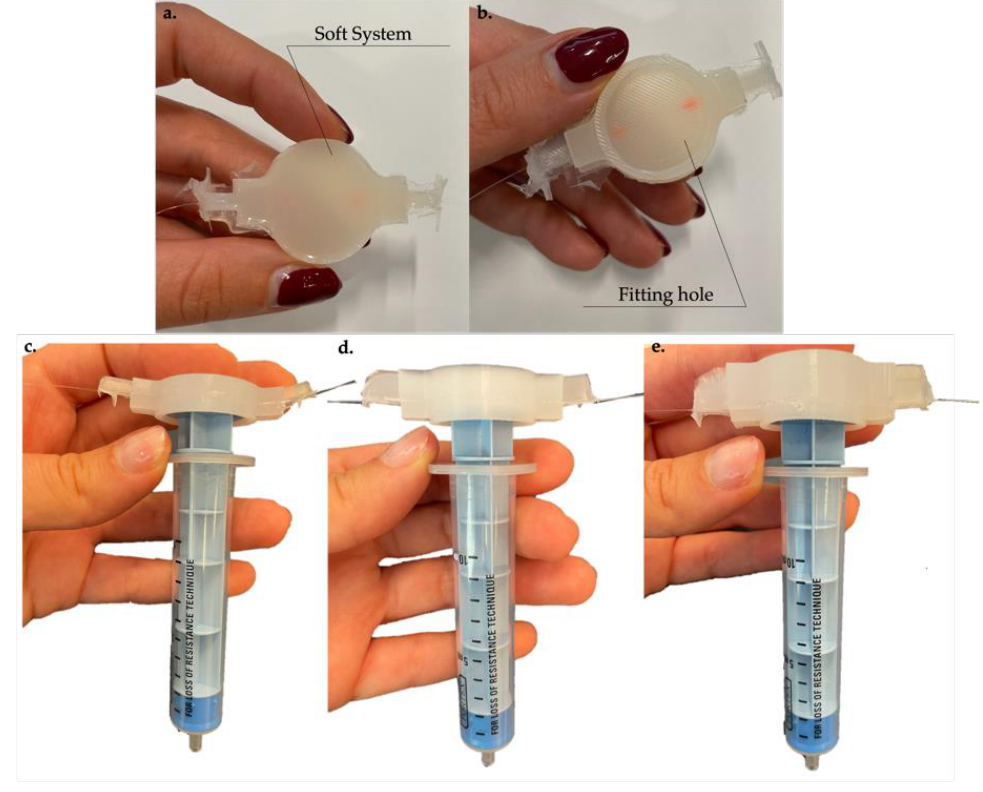
Figure 1. ( a ) One of the SSs developed. ( b ) SS mounting hole. ( c ) Arrangement on the LOR syringe